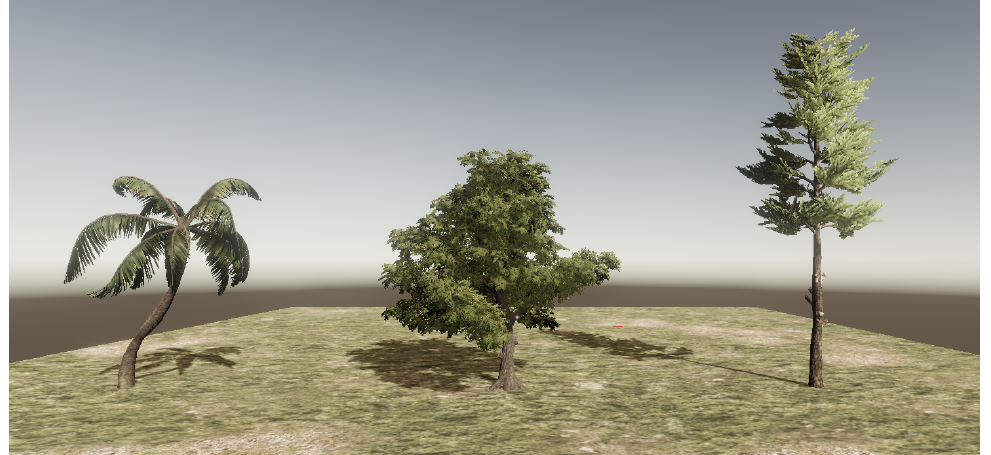
Figure 1. Three different types of tree used in the simulation, from left to right: palm trees, planifolia, and